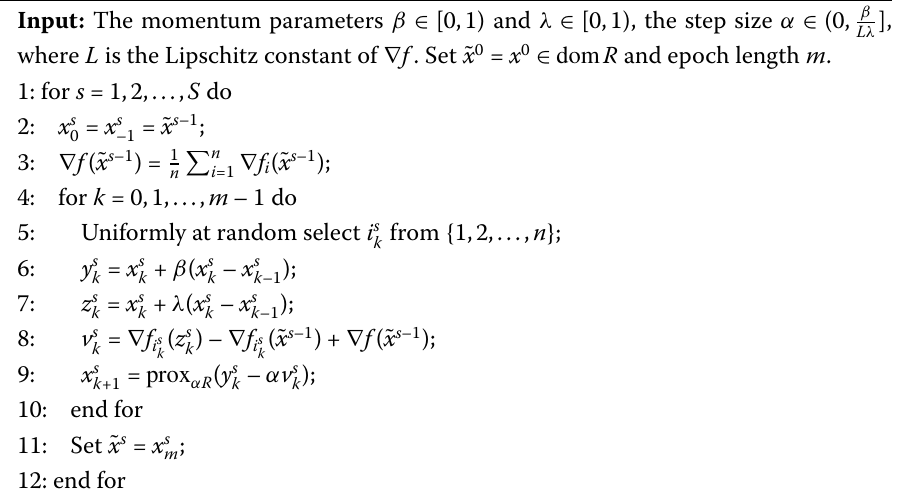
Algorithm 1 General inertia proximal stochastic variance reduction gradient: GIProx-